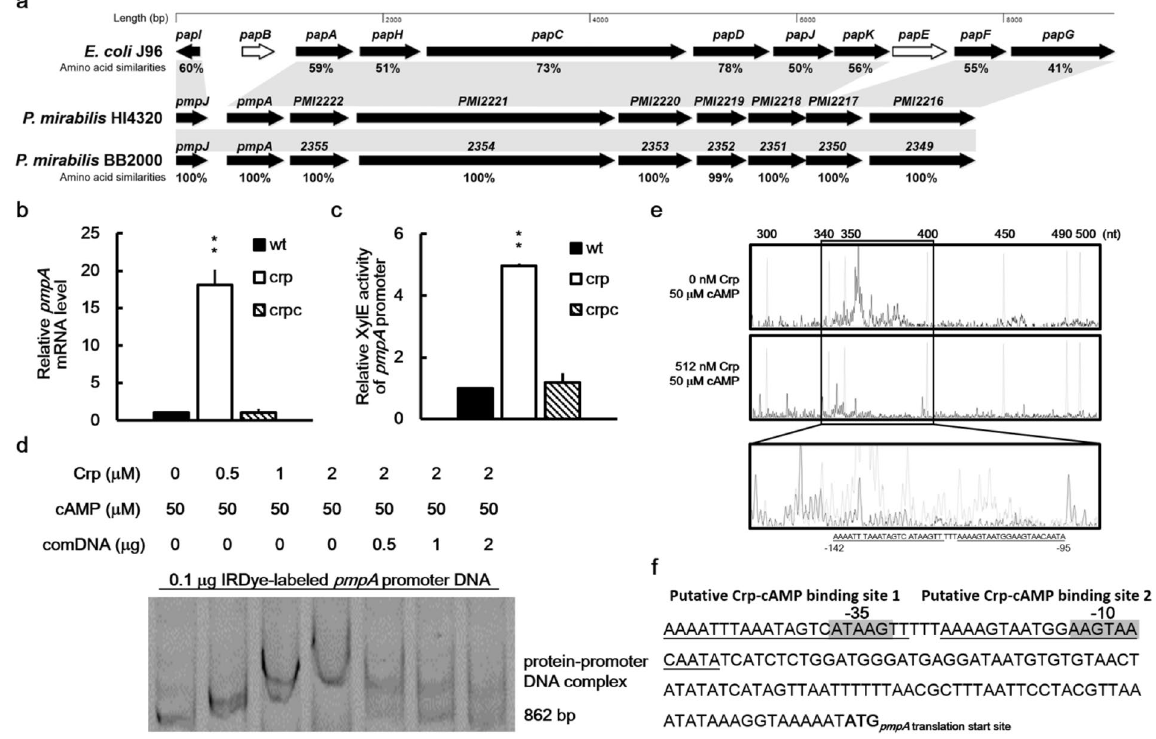
Figure 4. Regulation of pmpA expression by P . mirabilis Crp-cAMP. ( a ) The P-like fimbrial gene locus ( pmp ) similar to the well characterized pap locus in UPEC J96 in P . mirabilis genome. An amino acid sequence analysis of the pmp locus in P . mirabilis HI4320 (accession no. AM942759) and its counterparts in E . coli J96 (accession no. ALIN02000070) and P . mirabilis BB2000 (accession no. NC_022000) was performed using position-specific iterative BLAST. The nine proteins of the pmp locus in P . mirabilis HI4320 or BB2000 are similar to the PapI, PapA, PapH, PapC, PapD, PapJ, PapK, PapF and PapG in E . coli J96 with corresponding genes in shadows. The percent amino acid similarities between P . mirabilis HI4320 and E . coli J96 or P . mirabilis BB2000 were shown below each gene. The white arrows represent genes that are not found in either P . mirabilis HI4320 or P . mirabilis BB2000. ( b ) Loss of crp increased the pmpA mRNA level. The pmpA mRNA levels of the wild-type, crp mutant, and crp -complemented strain were quantified using real-time RT-PCR at 24 h after incubation. The value obtained for the wild-type was set at 1. ( c ) Loss of crp increased the promoter activity of pmpA . The activities of XylE in the pmpA-xylE reporter plasmid-transformed wild-type, crp mutant, and crp -complemented strain were determined using the reporter assay at 7 h after incubation. The value obtained for the wild-type was set at 1. In ( b and c ), the data represent the averages and standard deviations of three independent experiments. The significant difference from the wild-type was determined by Student’s t test ( ** P < 0.01). wt, wild-type; crp, crp mutant; crpc, crp -complemented strain. ( d ) The binding of P . mirabilis Crp-cAMP to pmpA promoter region revealed using an EMSA. The EMSA was performed as described in Fig. 3d, except that IRDye-labeled pmpA promoter region DNA fragments (862 bp) were incubated with 0–2 μ M of the purified His-tagged Crp. ( e ) Identification of the Crp-cAMP binding site in the pmpA promoter region by a DNase I footprinting assay. FAM was used to label the pmpA promoter DNA fragment and the DNA fragment was incubated with cAMP (50 μ M) with or without the recombinant Crp (512 nM) followed by DNase I treatment. The mixture was subject to electrophoresis. The fluorescence intensity of the FAM-labeled DNA fragment (ordinate) was plotted against the sequence length of the fragment. Two Crp-cAMP binding sites (underlined) located between − 95 and − 142 upstream of pmpA start codon were shown in an expanded view. ( f ) A diagram showing the Crp-cAMP binding sites upstream of pmpA gene. The putative Crp-cAMP binding sequences are underlined and the putative − 10 and − 35 promoter sequences of sigma 70 are shadowed. The full-length gel for ( d ) is shown in Supplementary Fig.